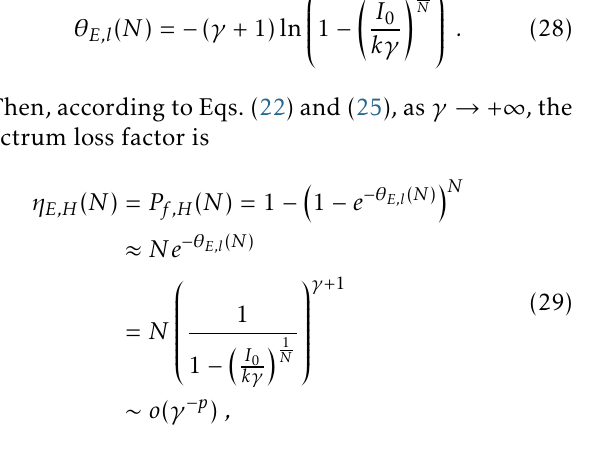
, together with kγ